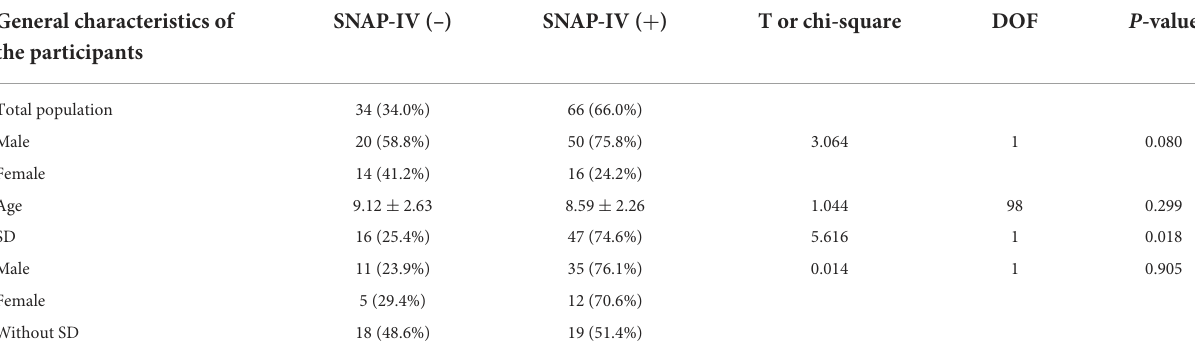
TABLE 1 General characteristics of the participants.